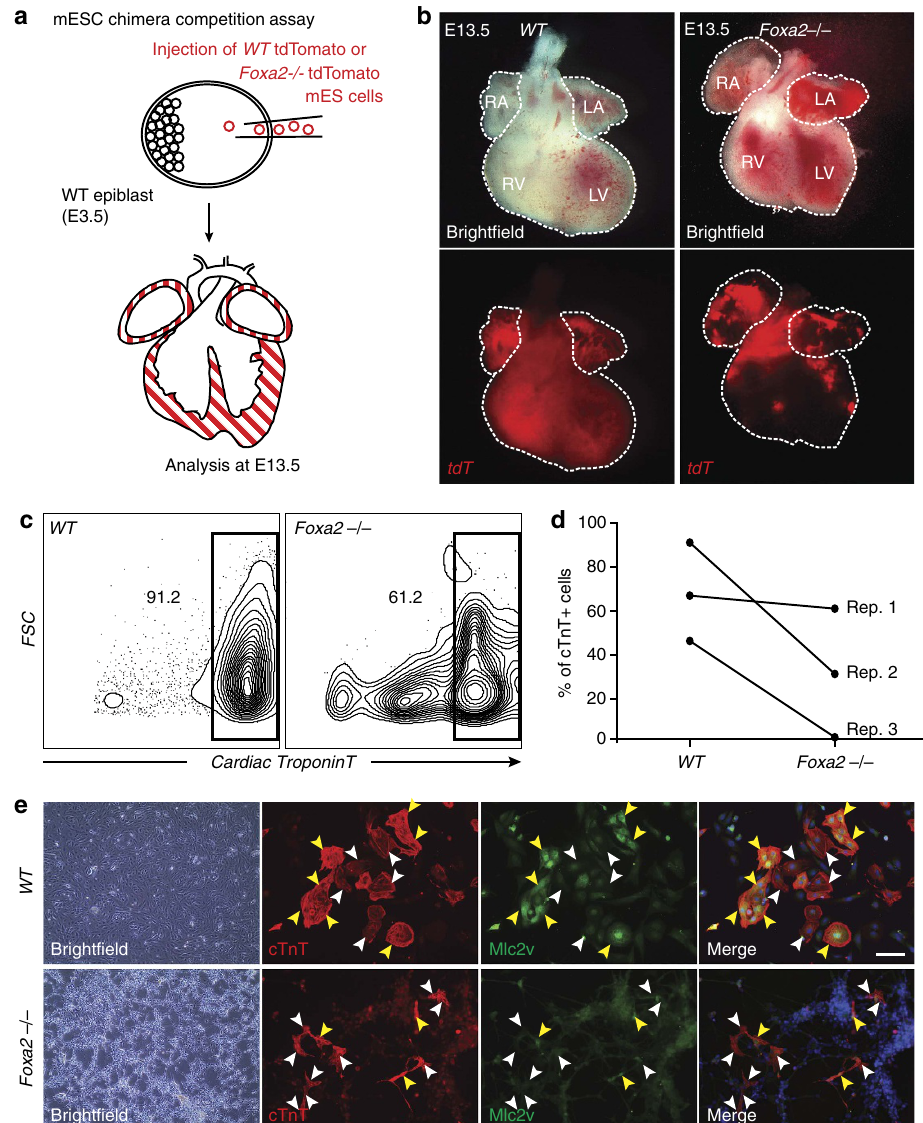
Figure 7 | Foxa2 is necessary for the generation of ventricular cells during cardiac development. ( a ) Schematic of mESC chimera competition assay. Fluorescently labelled WT or Foxa2 (cid:2) / (cid:2) mESCs are injected into unlabelled WT blastocysts at E3.5. Embryos are collected at E13.5 and the distribution of tdT þ cells is observed. ( b ) Whole-mount imaging of typical WT (left) and Foxa2 (cid:2) / (cid:2) (right) mESC-injected hearts at E13.5. ( c ) Flow cytometry analysis of cell populations differentiated from WT and Foxa2 (cid:2) / (cid:2) mESC cells. Cells at day 10 of differentiation were dissociated and analysed by flow cytometry for the cardiac marker cTnT. ( d ) Quantification of c . Paired data are plotted for n ¼ 3 replicates. ( e ) Cells at day 10 of differentiation from WT and Foxa2 (cid:2) / (cid:2) mESCs were plated and IF analysis was performed with antibodies against cTnT (red) and the ventricular-specific marker Mlc2v (green). Yellow arrowheads illustrate overlap of cTnTand Mlc2v. White arrowheads indicate cTnTcells that are not stained for Mlc2v. Scale bar, 50 m m. LA, left atria; LV, left ventricle; RA, right atria; RV, right